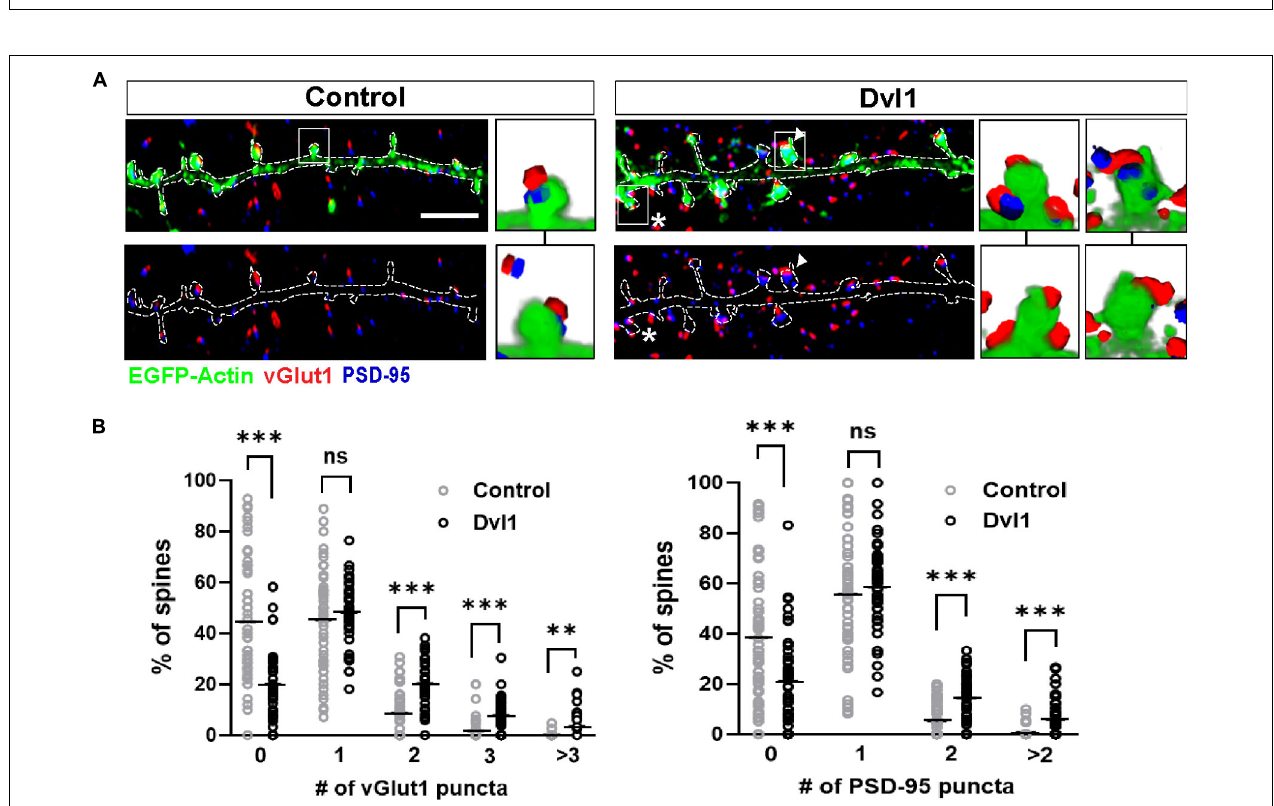
FIGURE 3 | Postsynaptic Dvl1 gain of function increases the innervation of spines and the formation of MIS. (A) Representative images of dendrites expressing EGFP-actin (green) and empty vector (control) or Dvl1-HA and immunostained for vGlut1 (red) and PSD-95 (blue). Dvl1 expression increases the proportion of spines contacted by more than one vGlut1 (asterisks) puncta and spines containing more than one discrete PSD-95 puncta (multiple PSDs; arrowhead) when compared to control neurons. Scale bar = 5 µ m. Three-dimensional zoomed-in images display front (top) and back (bottom) representations of spines with one or more vGlut1 and PSD95 puncta. (B) Quantification of the distribution of number of vGlut1 and PSD-95 puncta per spine ( n = 37–42 cells from 3 independent cultures, ** P < 0.01, *** P < 0.001, Mann-Whitney test).